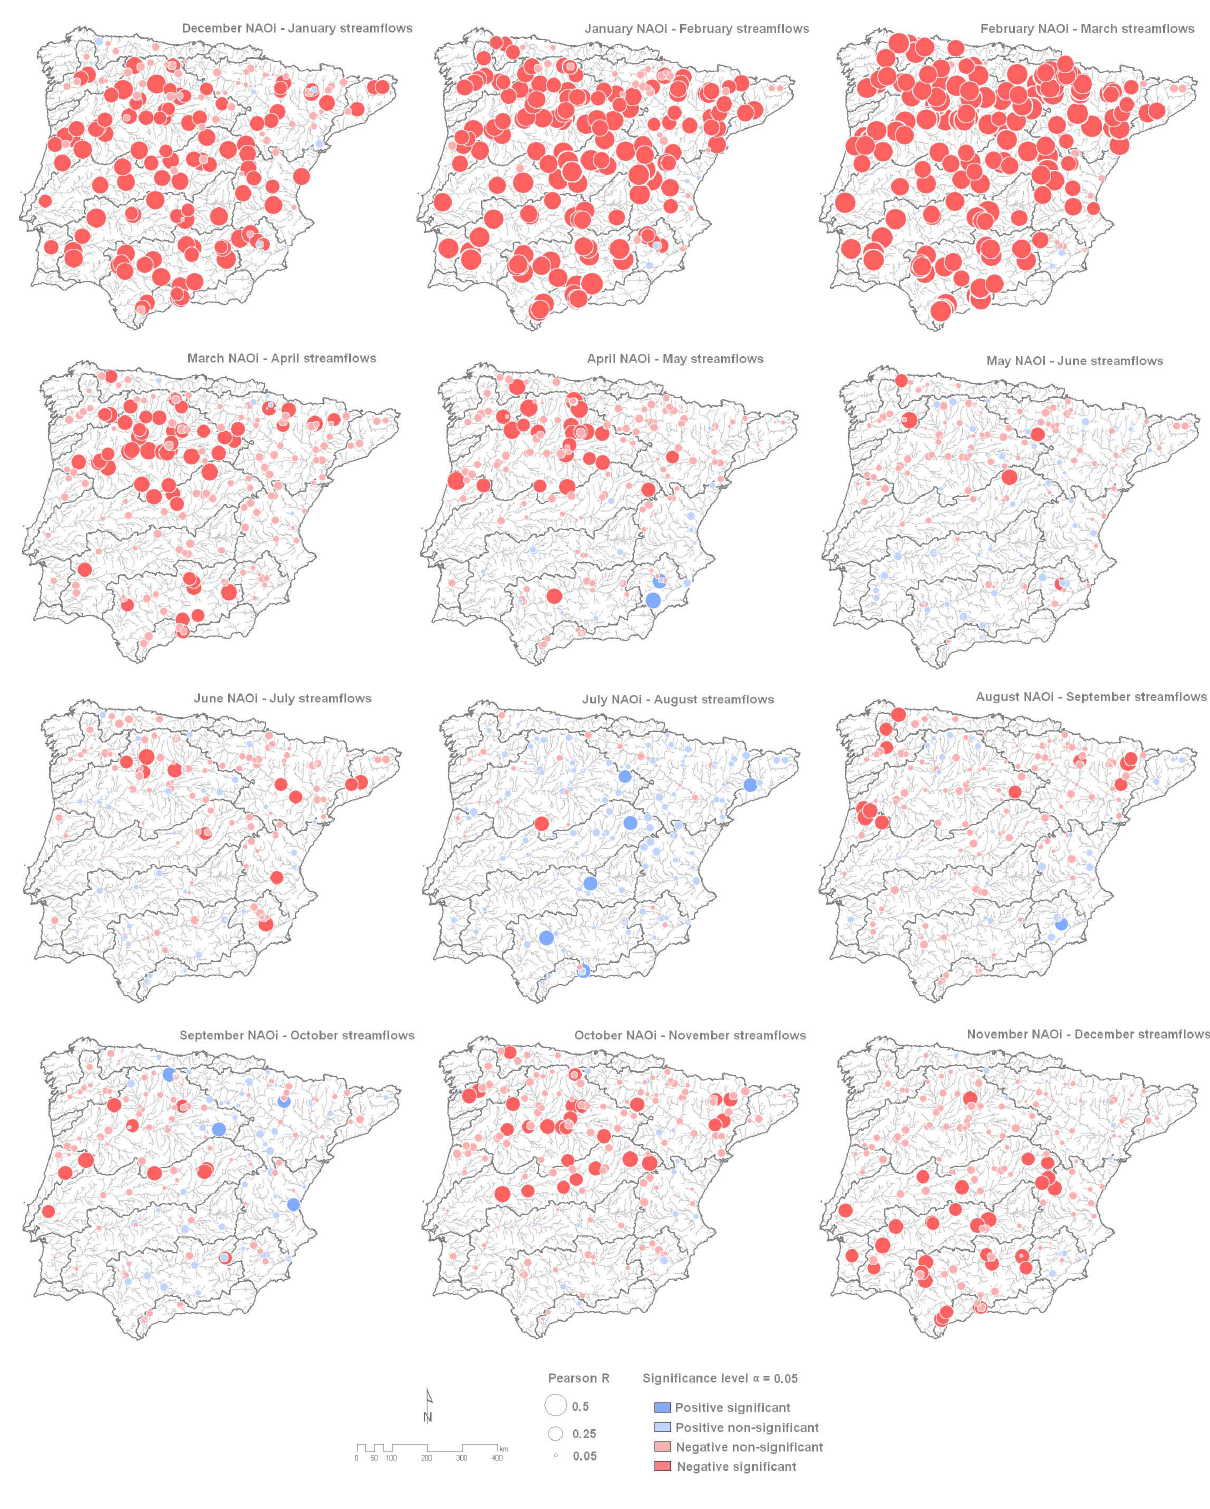
Fig. 3. Spatial distribution of the correlations between the monthly NAO index and the subsequent monthly SSI’s.